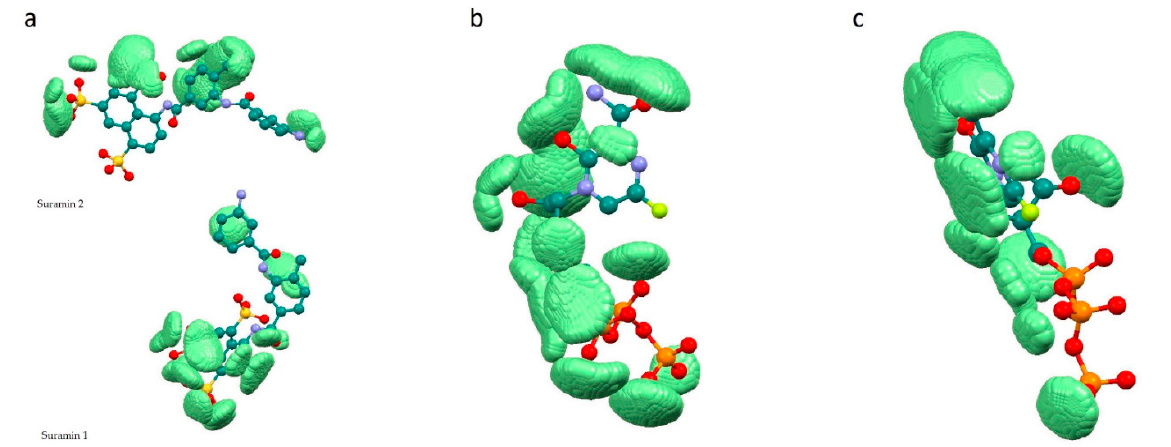
Figure 2. Complementary field (light green) of ligand—receptor complexes. ( ρ L > 0.001 a.u. and ρ E > 0.001 a.u.): ( a )—7D4F, ( b )—7CTT, ( c )—7AAP.